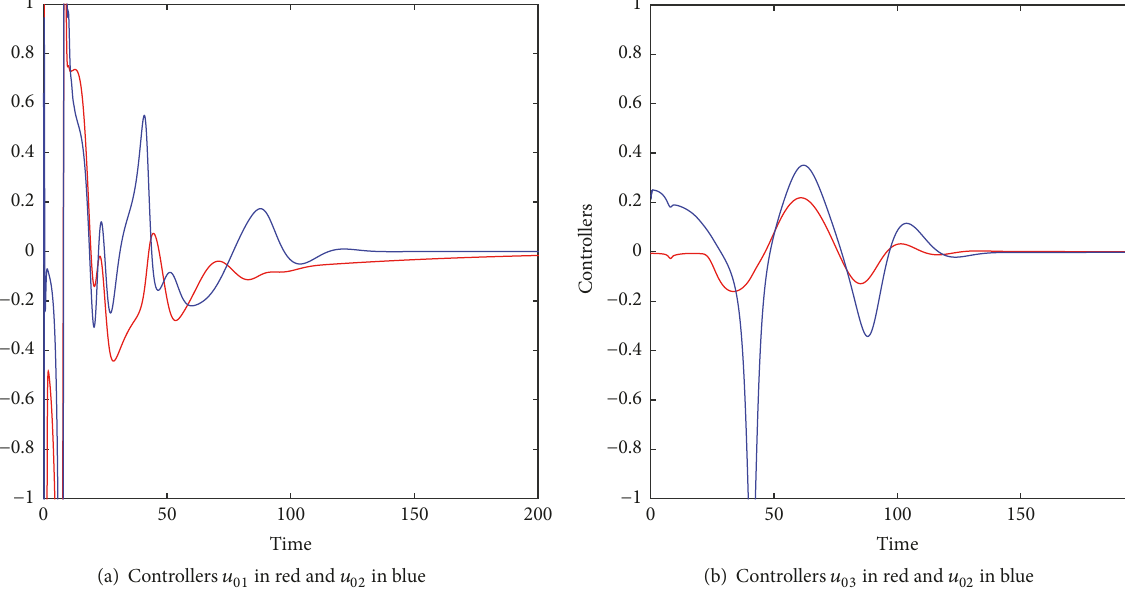
Figure 9: Controllers for end-effector of leader with 𝜎 = 0